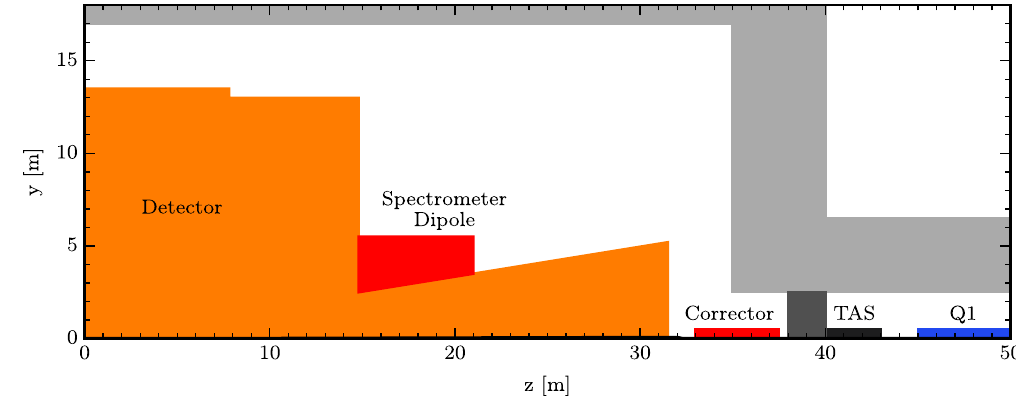
FIG. 11. Detector and interaction region layout leading to the L (cid:2) ¼ 45 m lattice. The IP is located at (0,0).